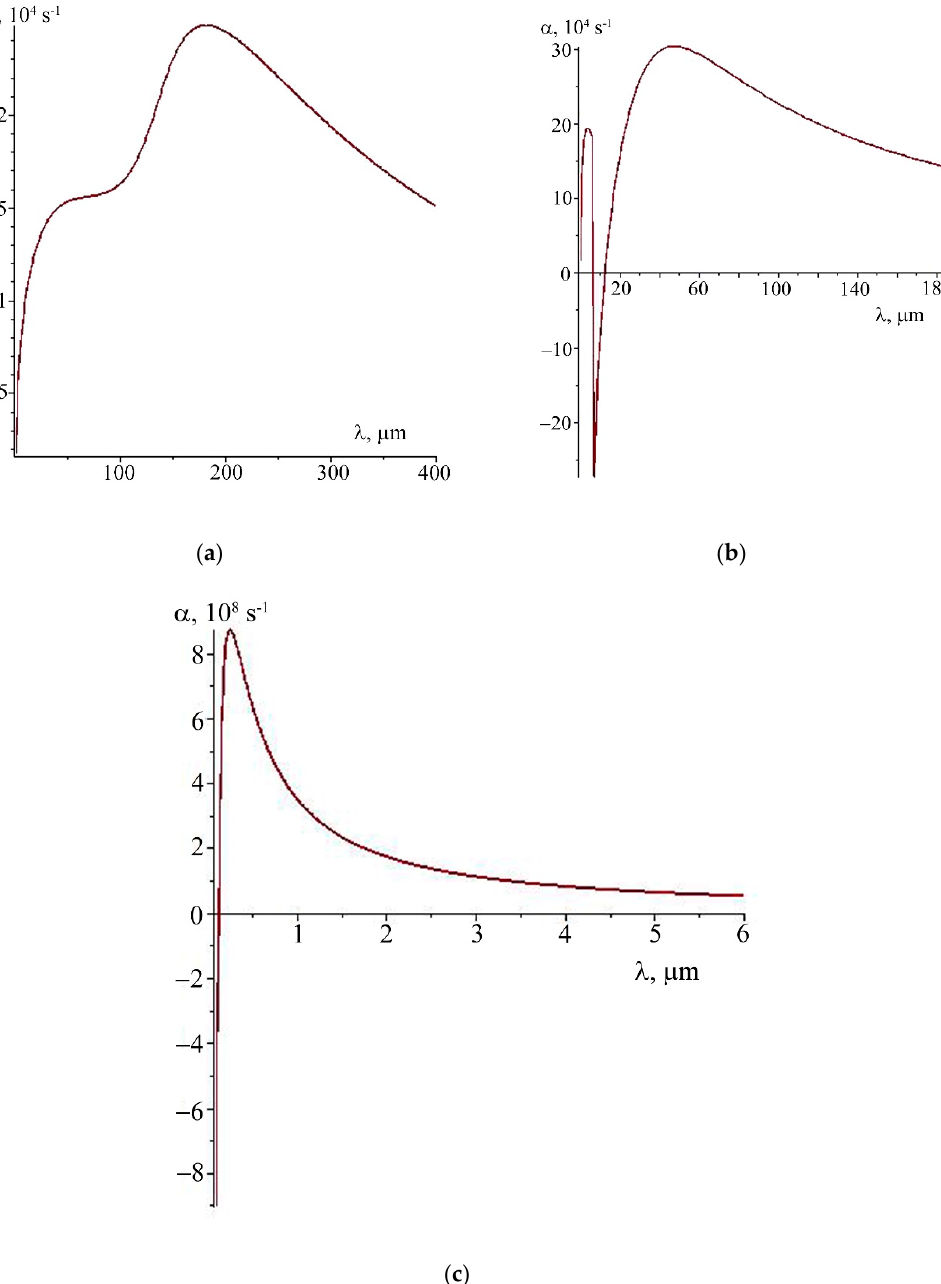
Figure 9. A growth rate characteristic of perturbations on the plasma–melt interface for the Al-Si-Y system found when solving the Equation (9): ( a ) ignoring thermoelectric and evaporation and capillary effects, ( b ) for thermoelectric field strength of 10 5 V/m, ( c ) for thermoelectric field strength of 10 6